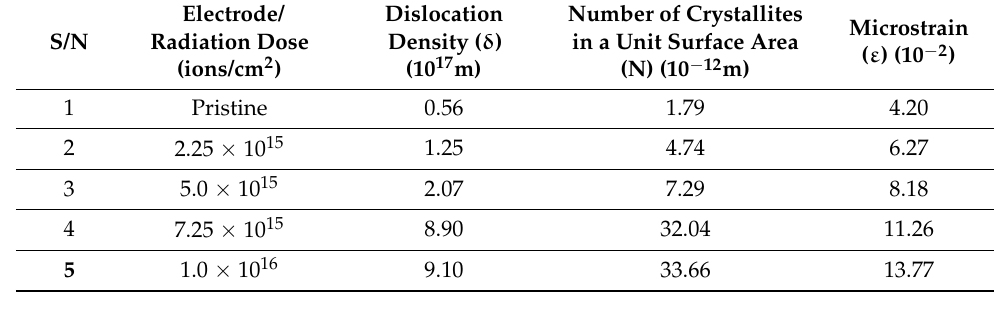
Table 1. Calculated structural parameters of Co 3 O 4 @MnO 2 @NiO/GO electrodes.